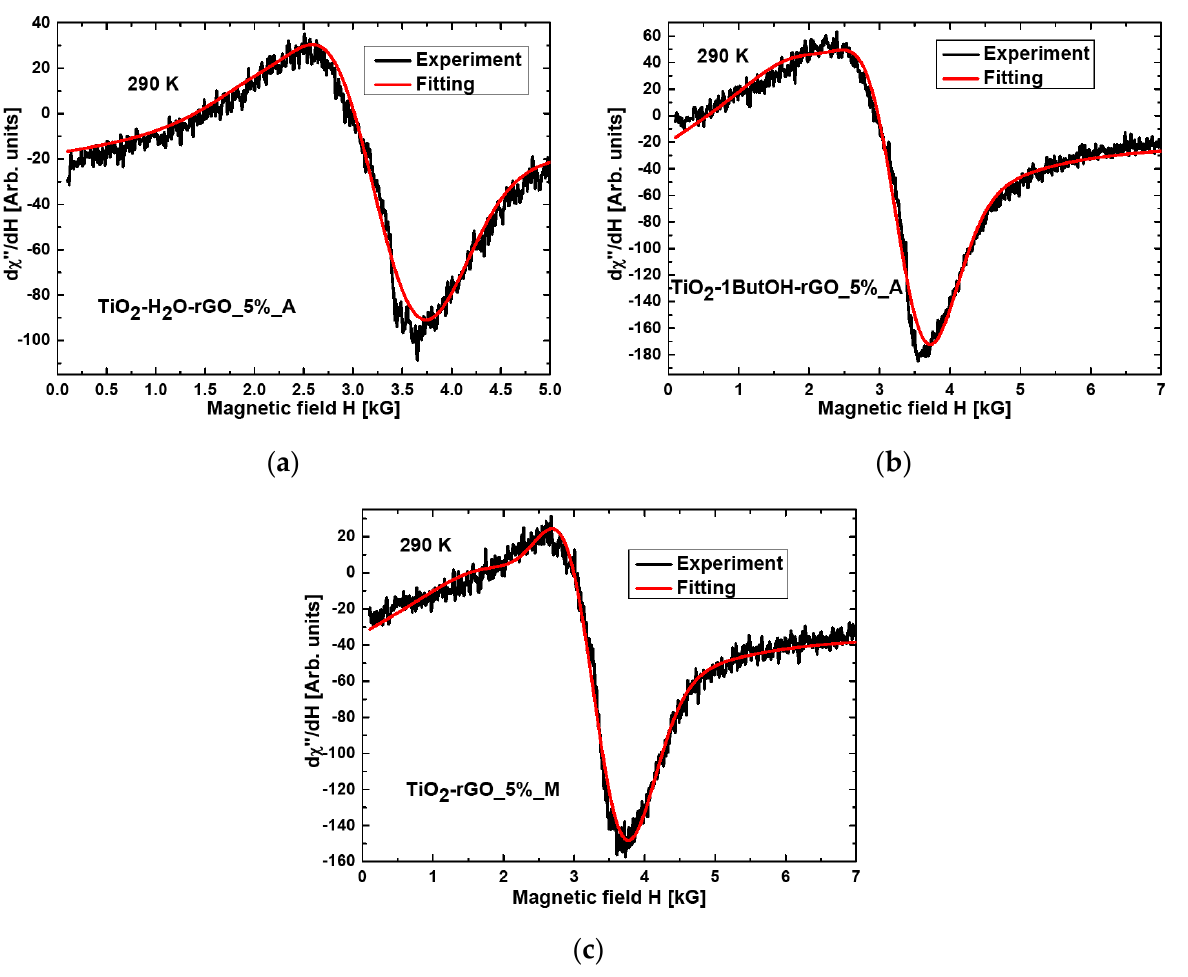
Figure 4. The fitting by Lorentzian and Gaussian function obtained for the nanocomposite ( a ) TiO 2 ‐